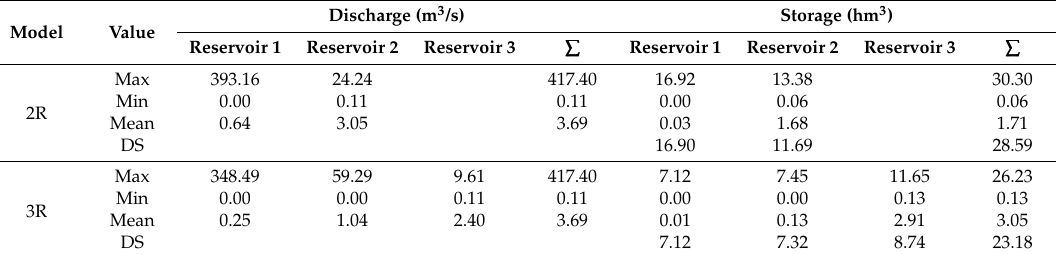
Table 7. Discharge and storage values for each reservoir. DS: dynamic storage.